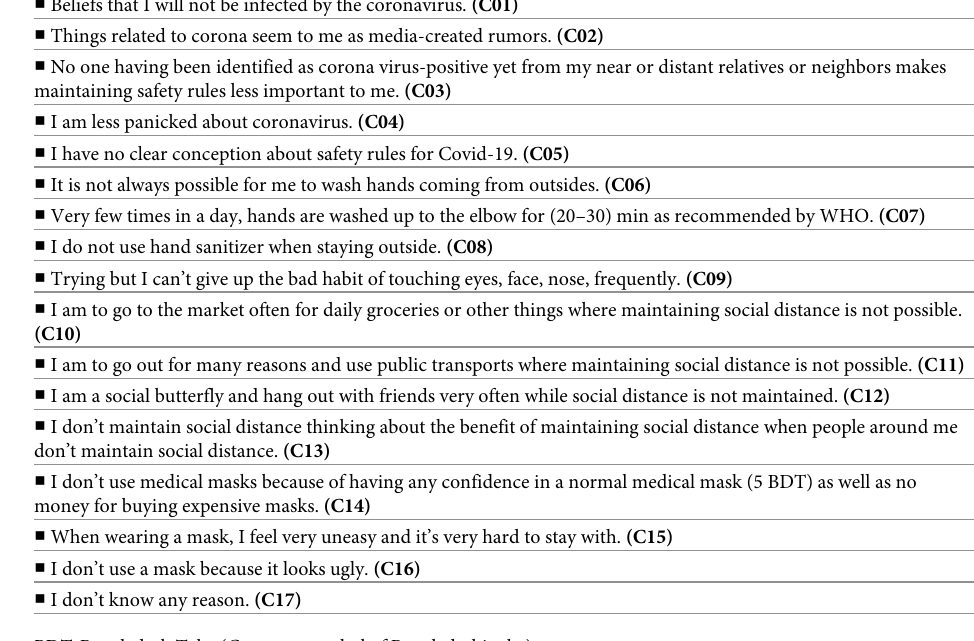
Table 7. Possible reasons why people cannot maintain safety rules of Covid-19 completely. ■ Beliefs that I will not be infected by the coronavirus.